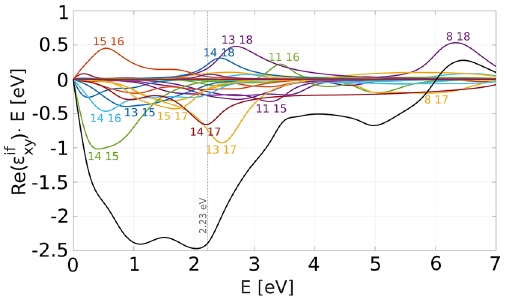
Figure 2. Individual contributions to the real part of the off-diagonal permitivity. The numbers denote the initial and final band indices. Black line represents the